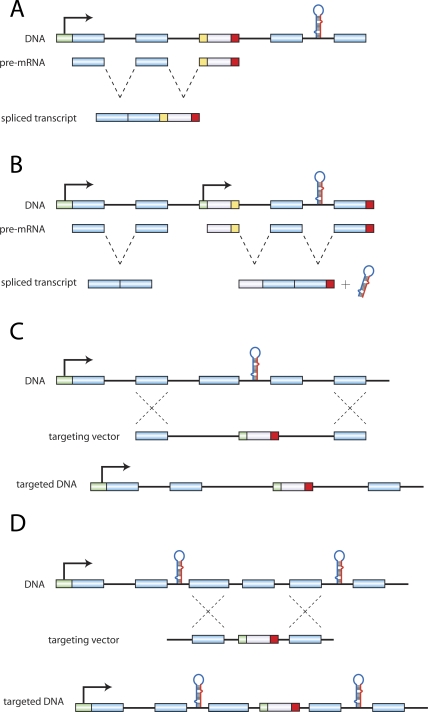
Configurations of Protein:miRNA Gene Disruptions.Retroviral gene traps have the potential to (A) ablate miRNA transcription or (B) lead to constitutive overexpression of the miRNA.(C) Schematic of a recombinant gene-targeting strategy whereby an intronic miRNA is ablated or (D) the miRNA is upstream and/or downstream of the targeting cassette. Promoter, green; exon, blue; selection marker, white; splice acceptor or donor, yellow; transcriptional terminator, red.